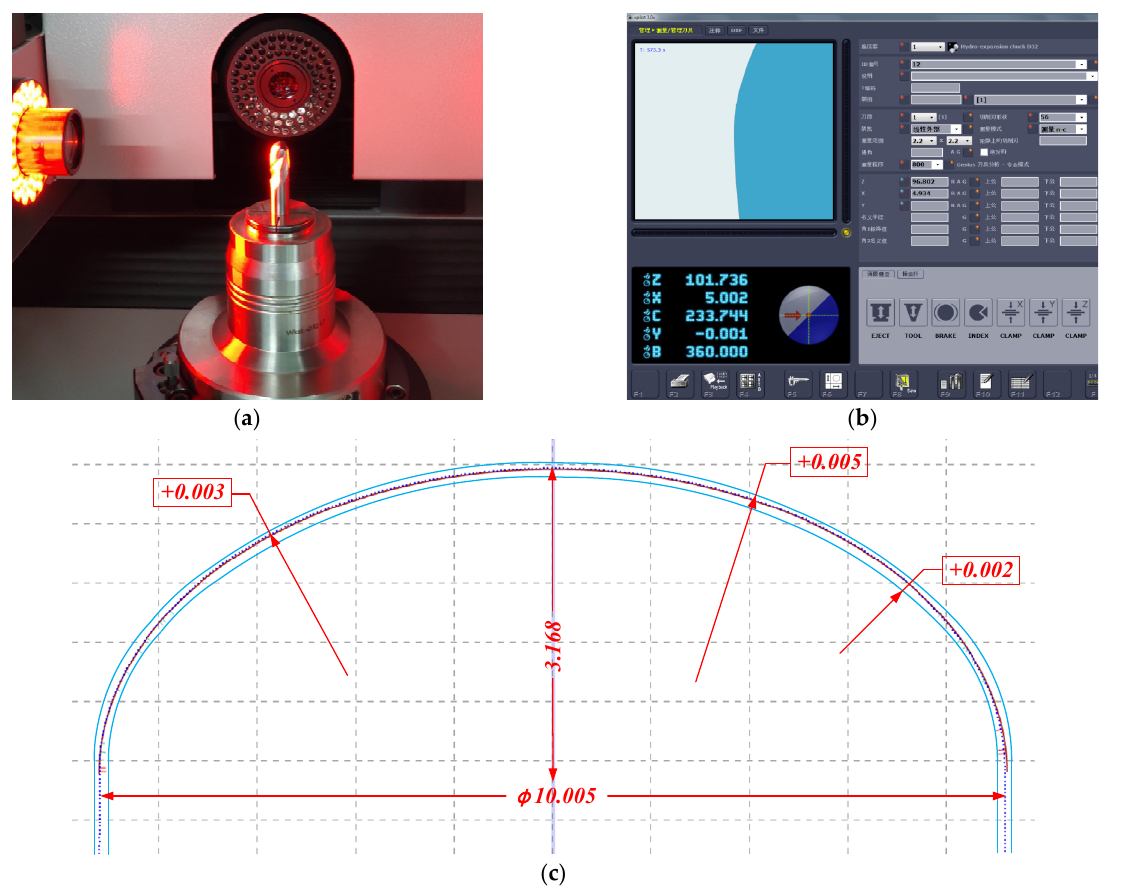
Figure 13. Geometric parameters detection results of DACT: ( a ) rake angle of DACT; ( b ) relief angle of DACT; ( c ) spiral angle of DACT; ( d ) flank face width of DACT.